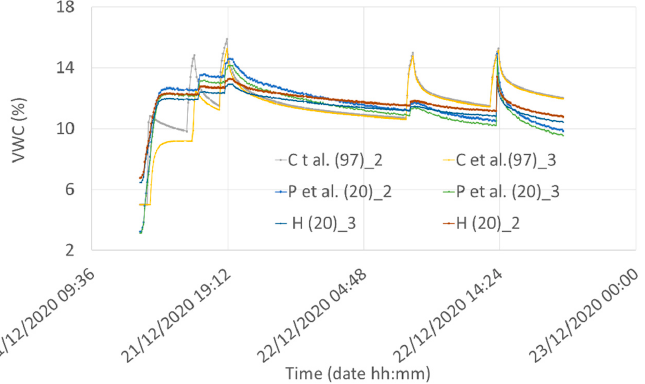
Figure 22. Comparison among the water infiltration and redistribution “C” model for Loamy Sand at a depth of 2 and 3 cm with the VWC obtained from the voltage measured by Node #1 using Equation (2) (“P” curves) and Equation (3) (“H” curves).